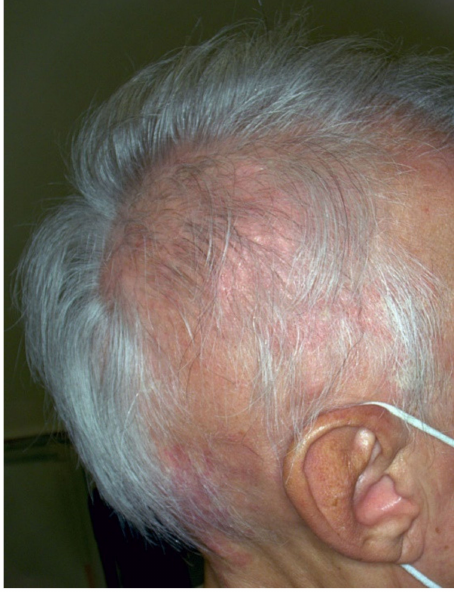
Figure 3. Diffuse patchy alopecia areata ICIs related on right parieto-occipital